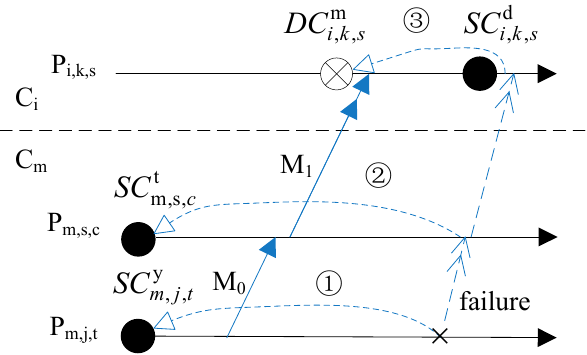
Figure 4. Example of rollback in different clusters.